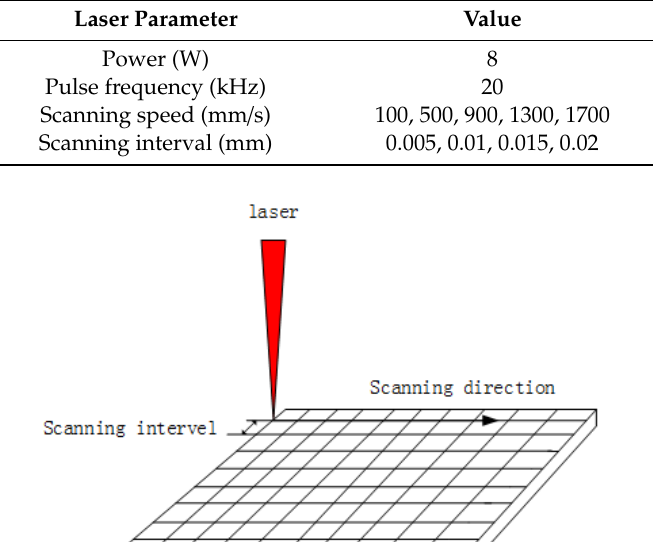
Table 1. Laser processing parameters.